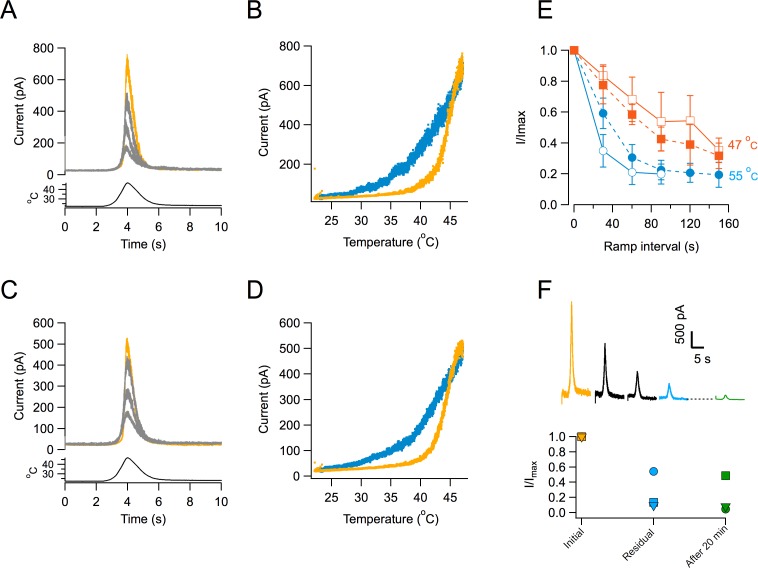
The presence of ATP fails to affect inactivation or produce recovery from inactivation.(A) Family of currents elicited by a temperature ramp applied at 30 s intervals in control solutions. Inside-out patch. Current amplitude is reduced with each consecutive ramp. (B) Current vs. temperature plot of the first ramp response from (A), showing the typical hysteretic activation profile of TRPV1 channels. Up-ramp response shown in yellow and down-ramp response in blue. (C) Response of a patch in the presence of 10 mM ATP to the same temperature ramp as in (A), showing the decrease of current with each stimulus. (D) Current vs. temperature plot of the first ramp response from (C), also showing hysteresis. Color code is the same as in (B). (E) Time course of current decay induced by multiple ramps. Two maximum ramp temperatures are shown. Empty symbols are the decay in control solution and filled symbols are the response in the presence of 10 mM ATP. The plot shows the mean ±s.e.m from five control inside-out patches and six patches in the presence of ATP. (F) The presence of ATP did not produce recovery of current after a recovery period of 20 min. Upper panel shows an experiment in which a ramp with a maximum temperature of 50°C applied four times produced a marked inactivation. After 20 min the ramp was re-applied and no current is recovered. Lower panel; summary from three experiments with varying degrees of inactivation, showing that the current is permanently lost, even in the presence of ATP. The color-coding corresponds to the traces in the upper panel. Each patch is shown with a different symbol.